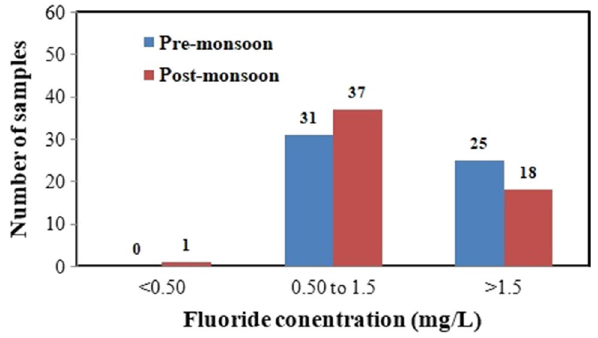
Fig. 7 Fluoride concentration for risk evaluation for drinking water in pre and post-monsoon